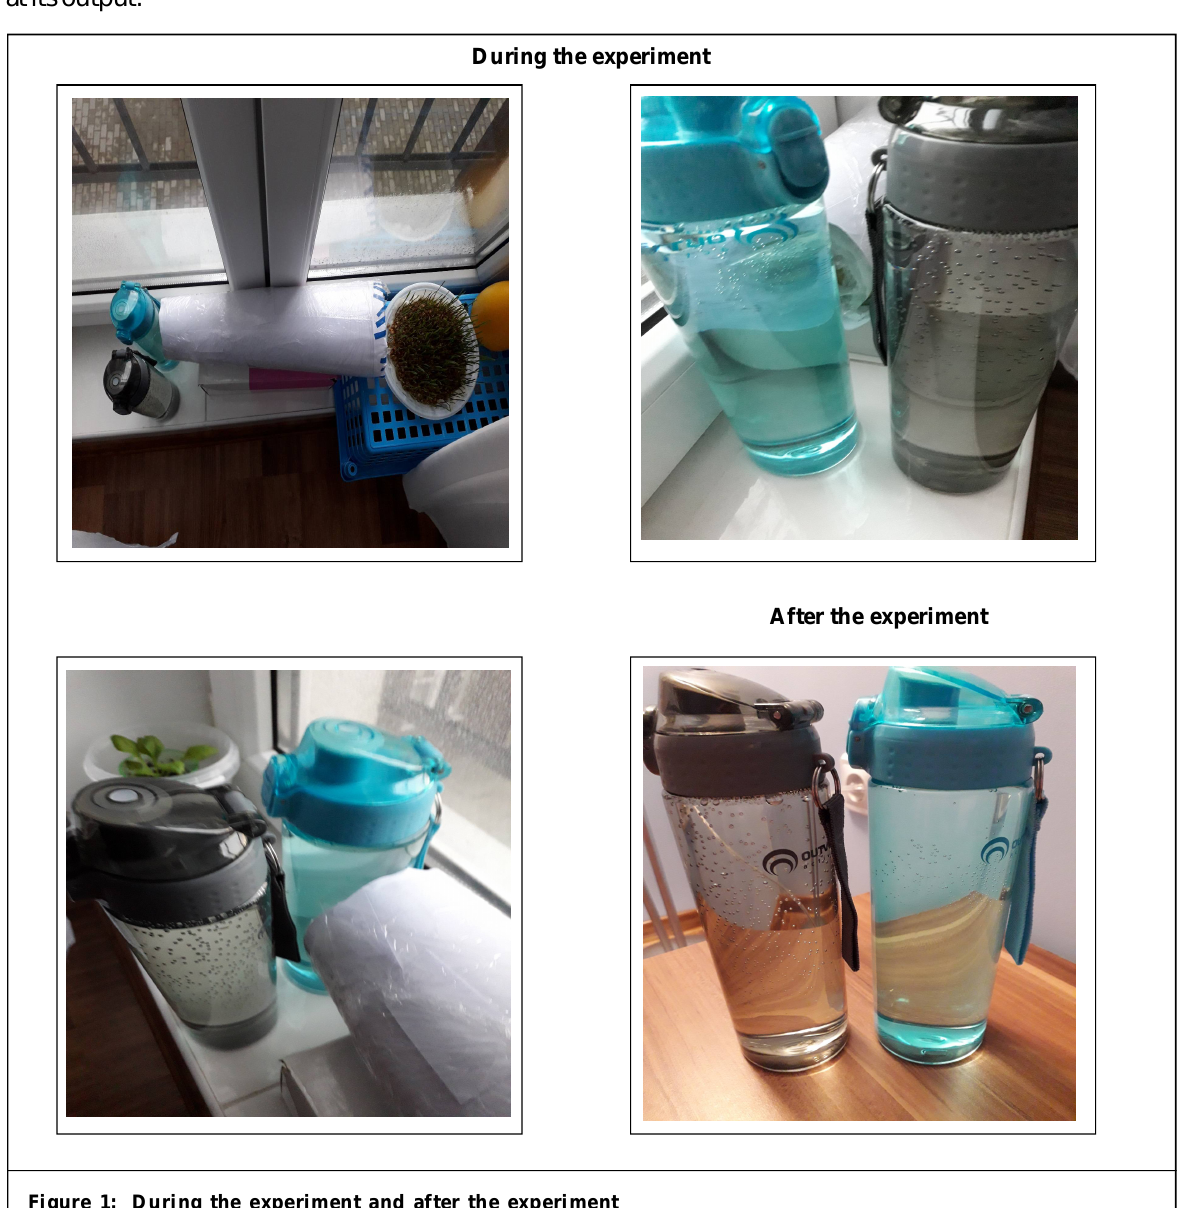
Figure 1: During the experiment and after the